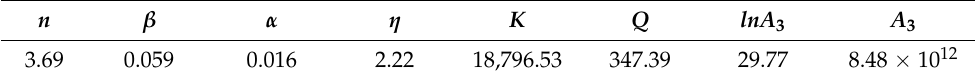
Table 8. Calculation results for the material constants of the constitutive model.